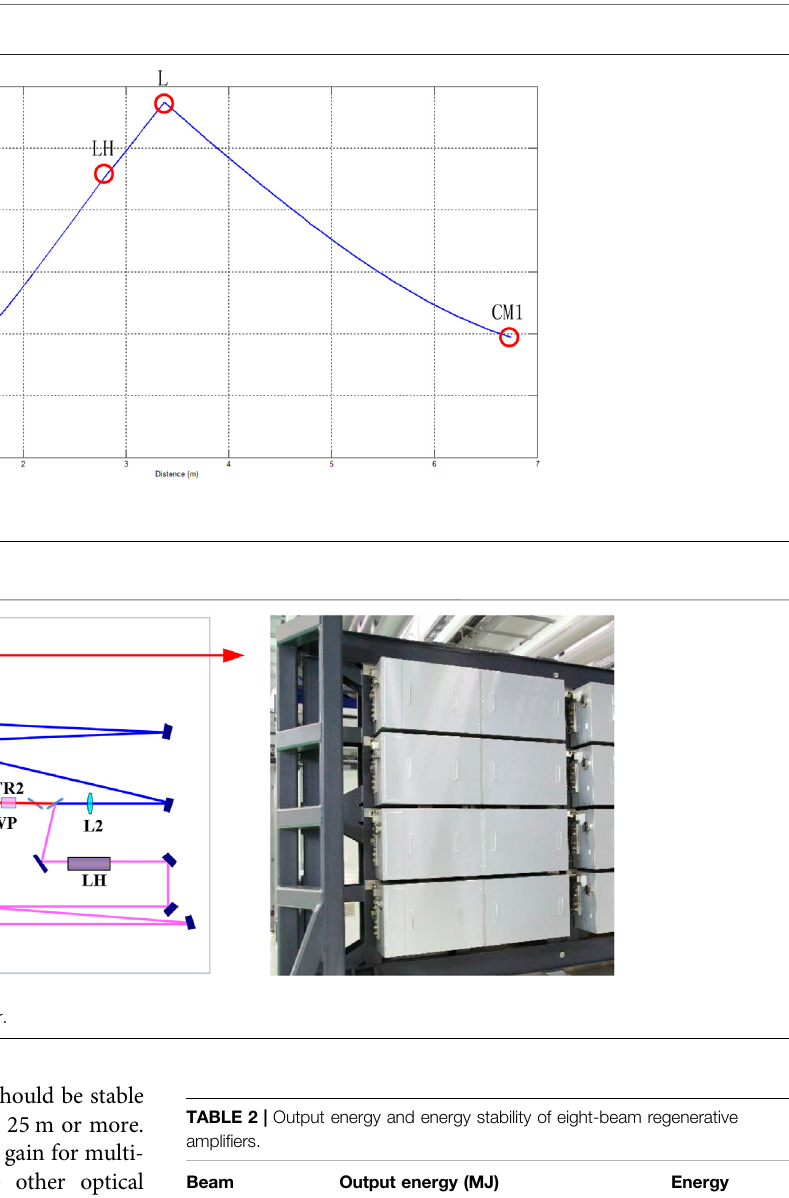
TABLE 2 | Output energy and energy stability of eight-beam regenerative ampli fi